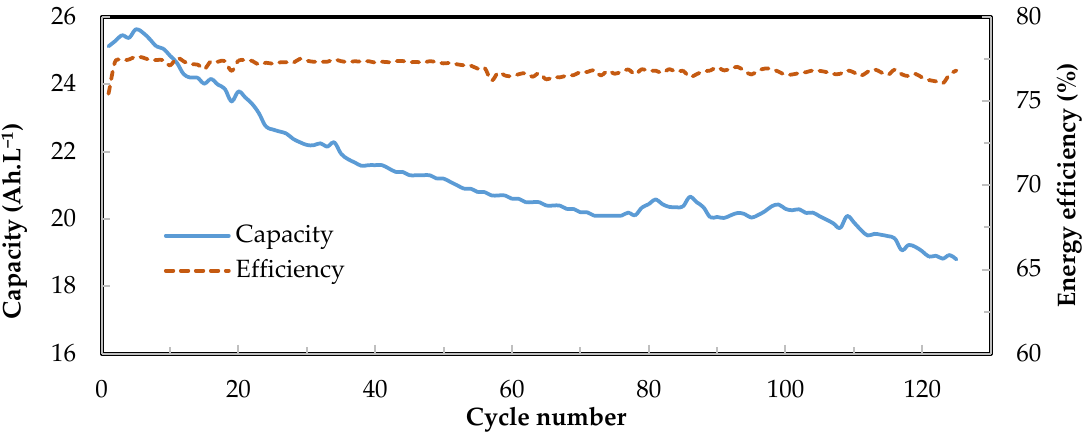
Figure 7. Capacity fade and energy efficiency of the 8 cell—1500 cm 2 stack over 125 cycles at current density of 60 mA.cm −2 and flow rate of 0.24 mL.min −1 .cm −2 .